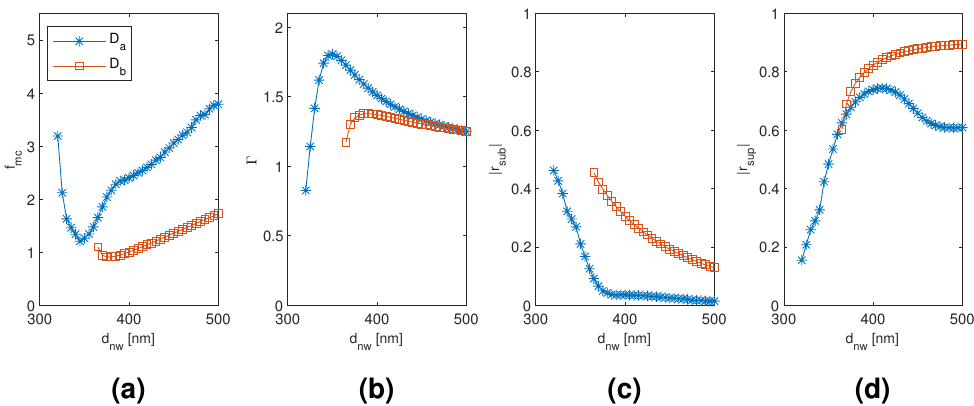
Figure 5. The results for the nanowire dimer D a and D b mode as a function of the diameter of the nanowires with the separation of the nanowires corresponding to the point of modal cost function minimum for each mode (as listed in Table 1). ( a ) modal cost function value; ( b ) modal confinement factor; ( c ) substrate modal reflection coefficient magnitude; ( d ) superstrate modal reflection coefficient magnitude.